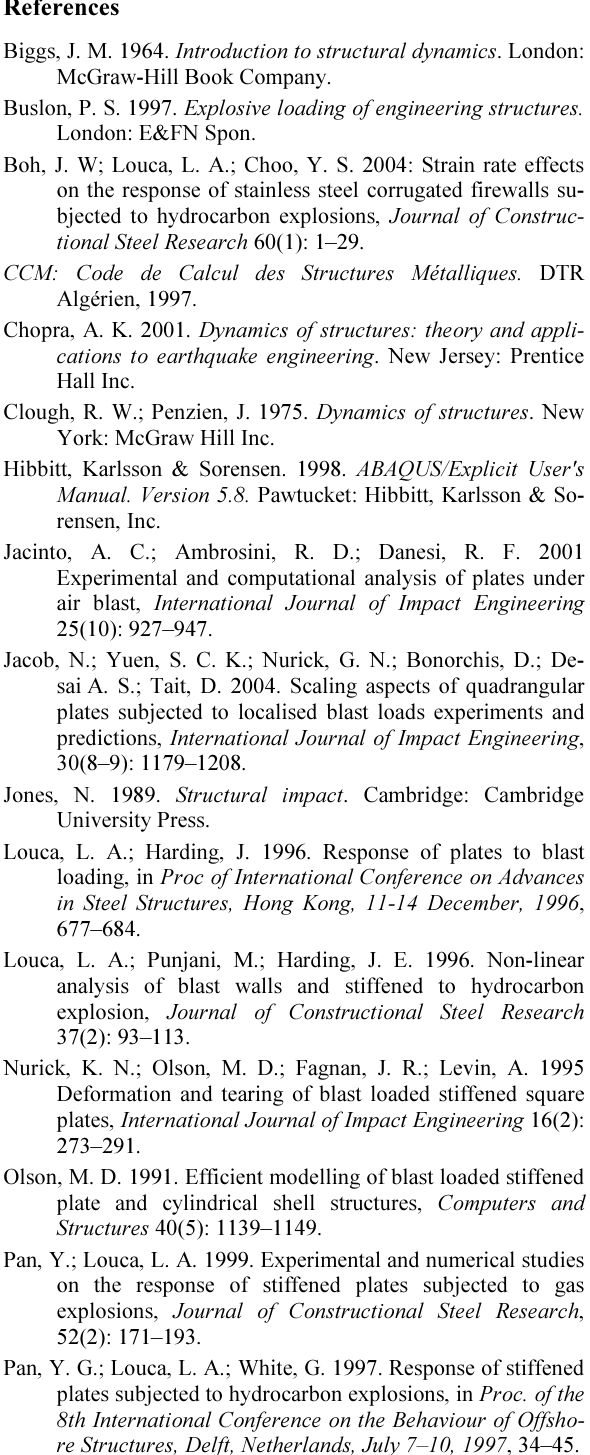
Fig. 12. History of plastic strain energy ( d